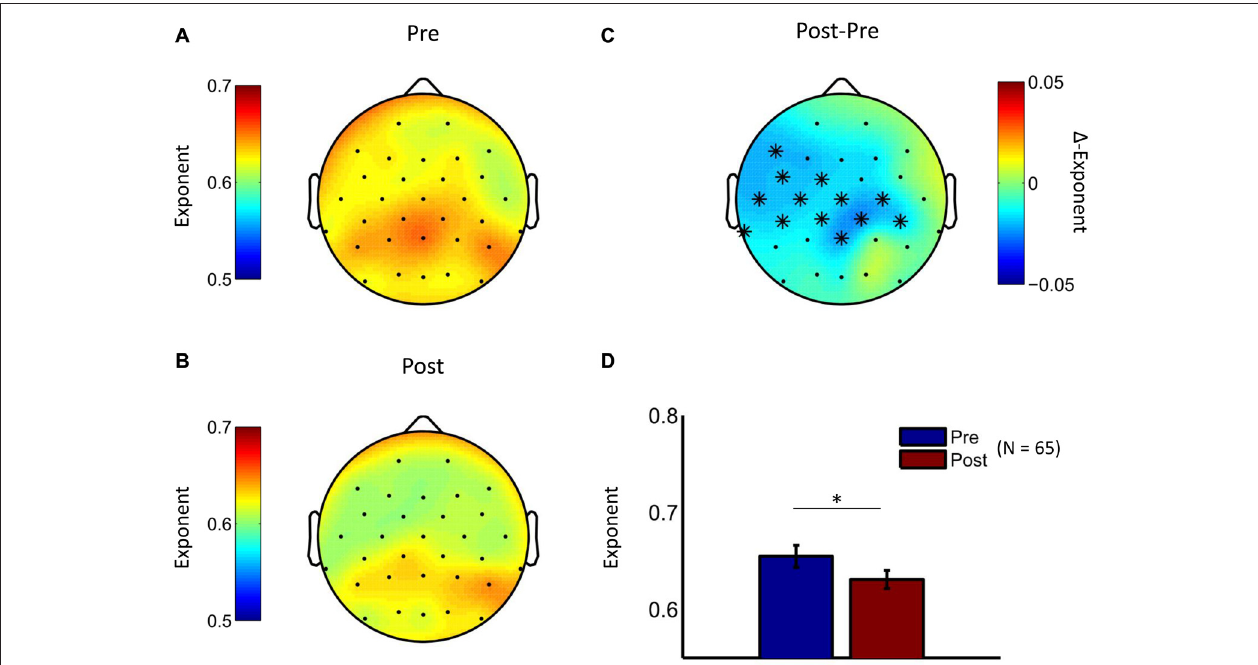
FIGURE 3 | LRTC in theta oscillations are reduced by psychological treatment. The topographic distribution of DFA exponents in theta oscillations is similar for the baseline measurement (A) and the post-treatment measurement (B) for the pooled treatment groups. (C) The difference topography (Post minus Pre) indicates widespread reductions in LRTC due to interventions. Cluster-based permutation statistic revealed a significant cluster at widespread electrode locations (cluster-electrodes are marked with a star). (D) Mean exponent values at a central cluster-electrode (Pz, t -statistic, ∗ p < 0.05).